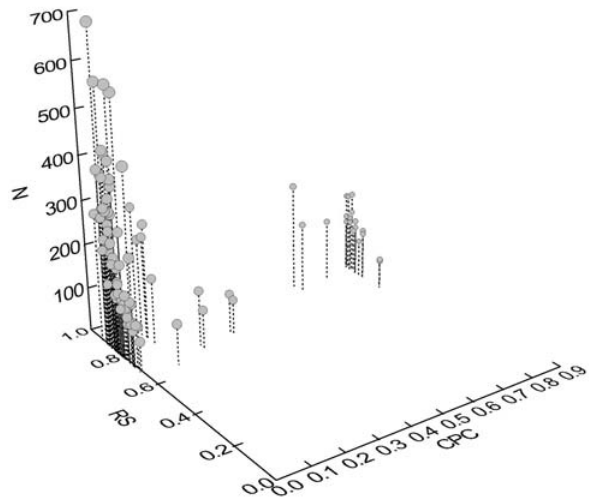
Figure 2 - Bivariate distribution of CPC and RS matrix similarity results. Notethatmatricesdeemedverysimilarbyrandomskewers(RS)arefound